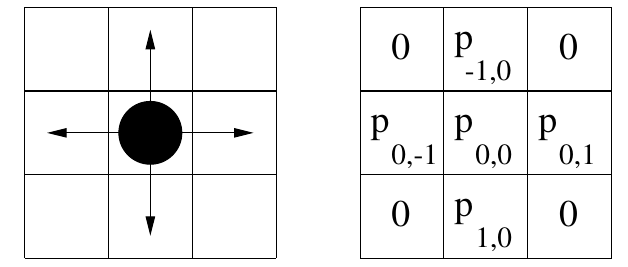
Figure 5 Possible target cells for a person at the next time